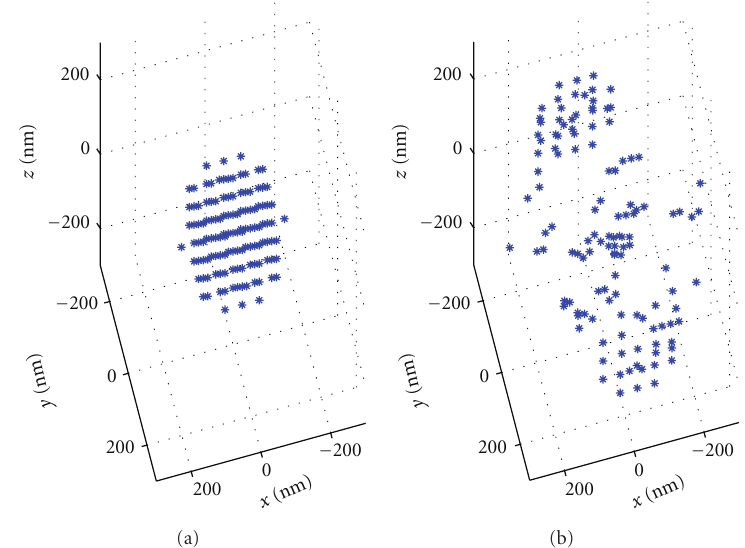
Figure 4: The positions of the scatterers in the initial (not optimized) cluster and in the cluster optimized for the minimal scattering. The reflectance was optimized for the normalized frequency k 0 L = 0 . 11 at the observation point r ob = { 0 . 87,0 . 5,0 . 00 } . The period of the initial cluster is d = 5 L and L =